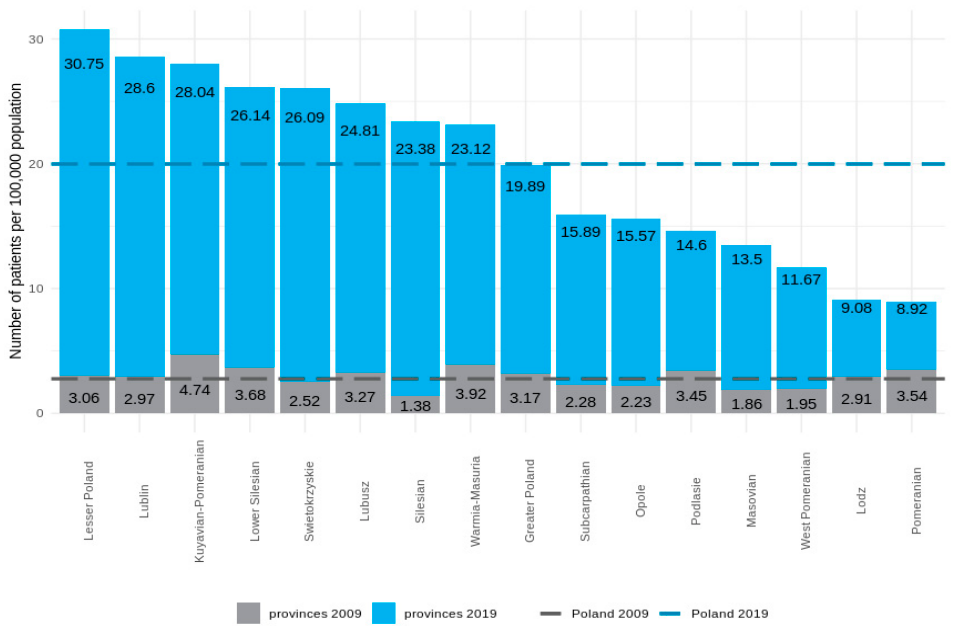
Figure 4. Prevalence of HMV (adults and children combined) in individual provinces in 2009 (grey) and 2019 (blue). The horizontal line represents the average for Poland in 2009 (bottom line) and 2019 (top line).